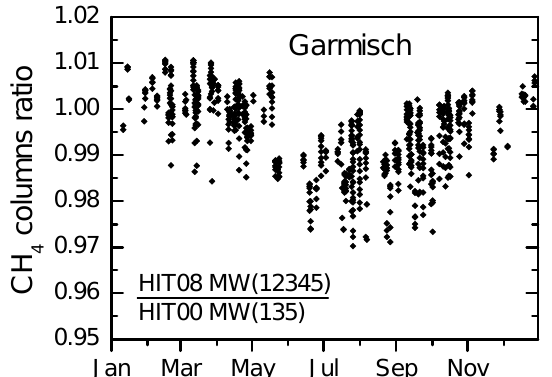
Fig. 6. Ratio of one year of Garmisch year 2007-methane retrievals with two differing retrieval strategies, i.e. using all 5 candidate mi- cro windows and HITRAN 2008 (HIT08 MW (12345)) versus us- ing only micro windows number 1, 3, and 5, and HITRAN 2000 (HIT00 MW (135)) plotted as a time series.